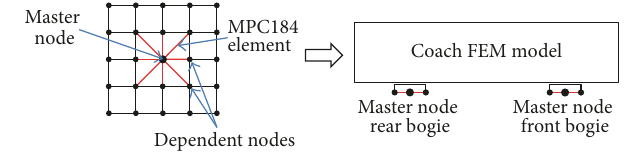
Figure 10: Connection of the mesh nodes near the master node with MPC184